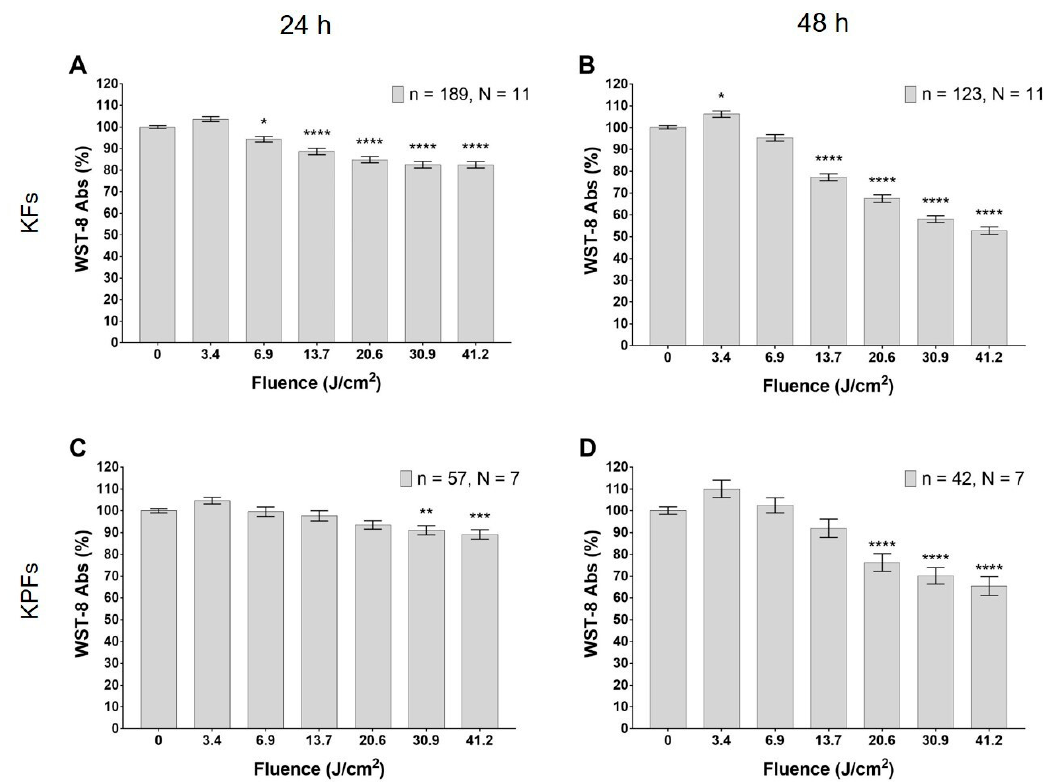
Figure 5. E ff ects of blue LED light on cell metabolism in human keloid fibroblasts. ( A , B ) Metabolism 24 and 48 h after the treatment in keloid fibroblasts, respectively. ( C , D ) Metabolism 24 and 48 h after the treatment in perilesional keloid fibroblasts, respectively. Data are expressed as mean ± SEM. Each measure is repeated in triplicate at 24 h and in duplicate at 48 h after treatment. Statistical analysis: * p < 0.05; ** p < 0.01; *** p < 0.001; **** p < 0.0001 vs. control (not irradiated cells), one-way ANOVA followed by Dunnett’s multiple comparison test.